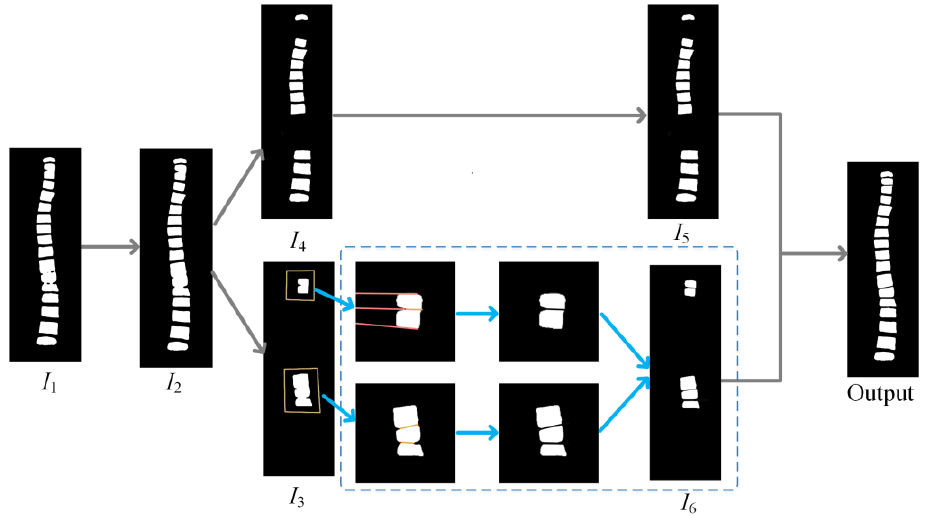
Figure 4. The post-processing for segmentation